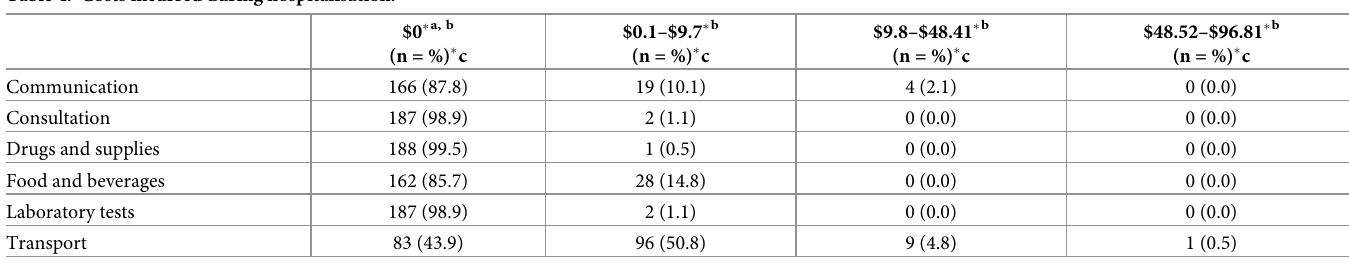
Table 4. Costs incurred during